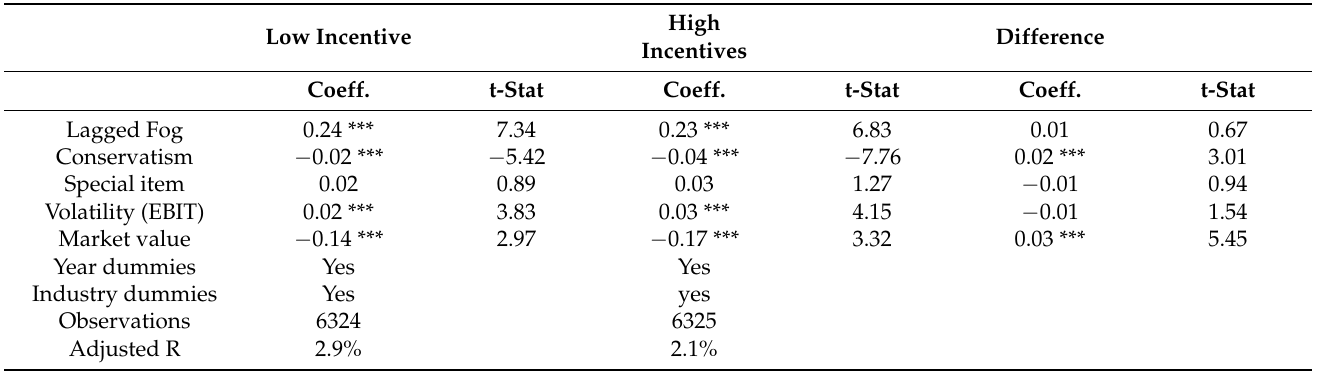
Table 4. Test of Hypothesis 2: Dependent Fog in high-(low-)incentive subsample. High Low Incentive Difference Incentives Coeff. t-Stat Coeff. t-Stat Coeff.